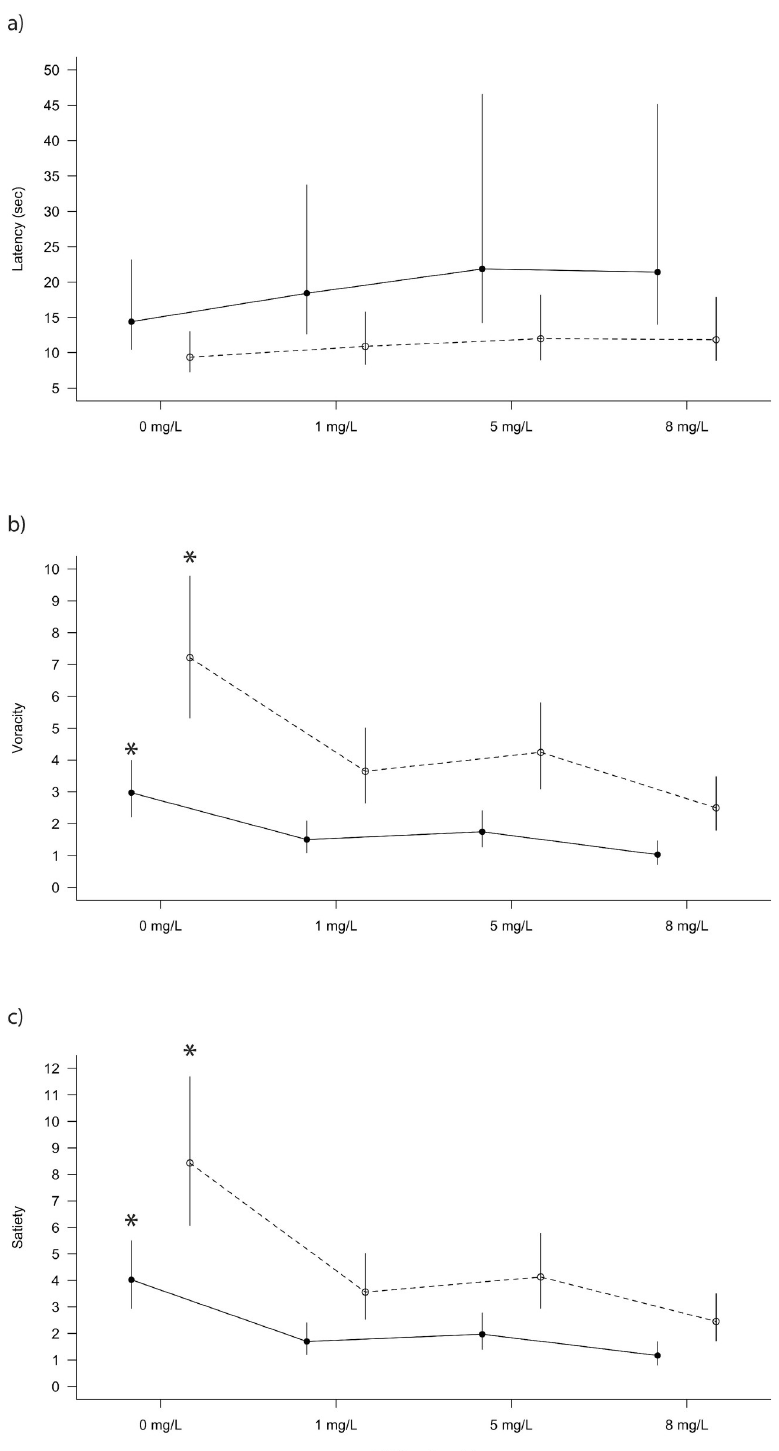
Fig 3. Feeding behaviour of B . meridionalis exposed to the TAN treatments during the experiment. (a) Latency (time taken to start touching the food), (b) Voracity (number of red chironomid larvae eaten in one minute), and (c) Satiety (total number of red chironomid larvae fish eaten) are shown for the pre-exposed fish from the polluted site (black points and solid lines), and the non pre-exposed fish from the unpolluted site (white points and dashed lines). � indicates significant differences ( P < 0.05) between the control concentration and the TAN treatments, following a generalized linear mixed model (GLMM). https://doi.org/10.1371/journal.pone.0243404.g003 PLOS ONE | https://doi.org/10.1371/journal.pone.0243404 August 9,